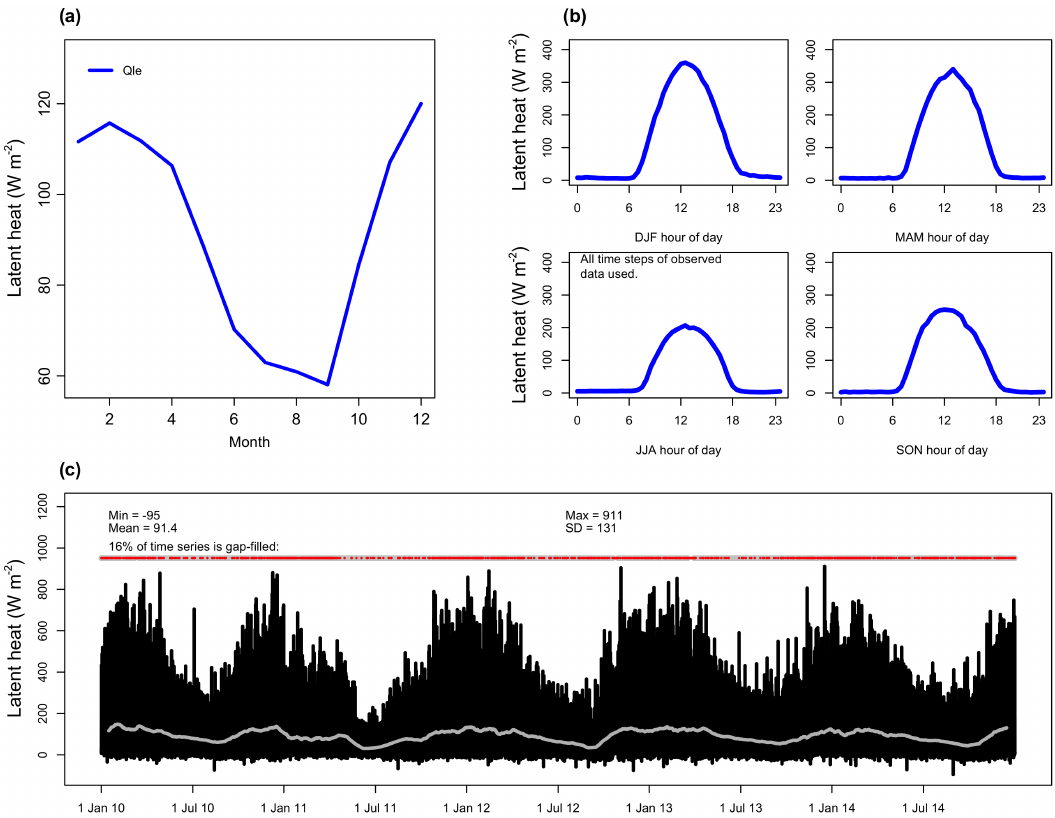
Figure 2. Examples of output plots produced by the package. Mean annual cycle by month is shown in panel (a) and mean diurnal cycle by season in panel (b) . A time series is plotted in (c) , with the full time series shown in black and a smoothed 14-day running mean in grey. Gap-filled periods are indicated in